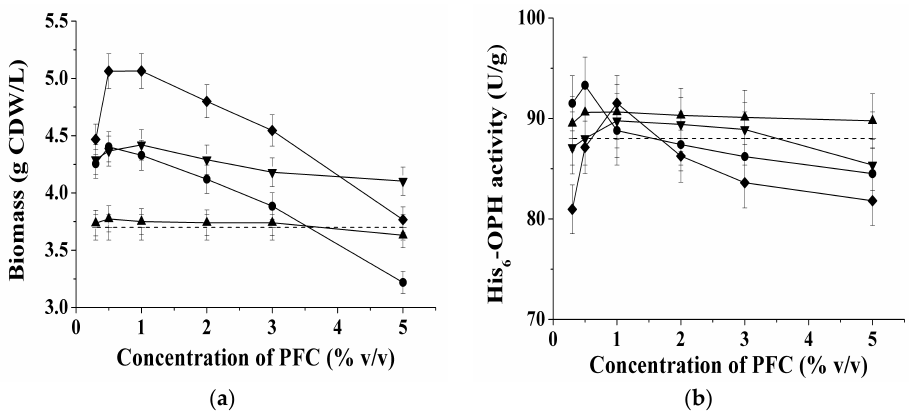
Figure 1. The accumulated biomass of E. coli SG13009[pREP4] cells ( a ) and His 6 -OPH-activity in the cells ( b ) vs. initial concentration of the additive (●—PFH, —polyether I, ▲— PFD, ♦ —polyether II) Control sample (without PFC additives) is marked by dashed line. Table 2. Specific cell growth rate ( µ , h − 1 ) for E. coli SG13009[pREP4] for various concentrations of PFCs in the culture medium